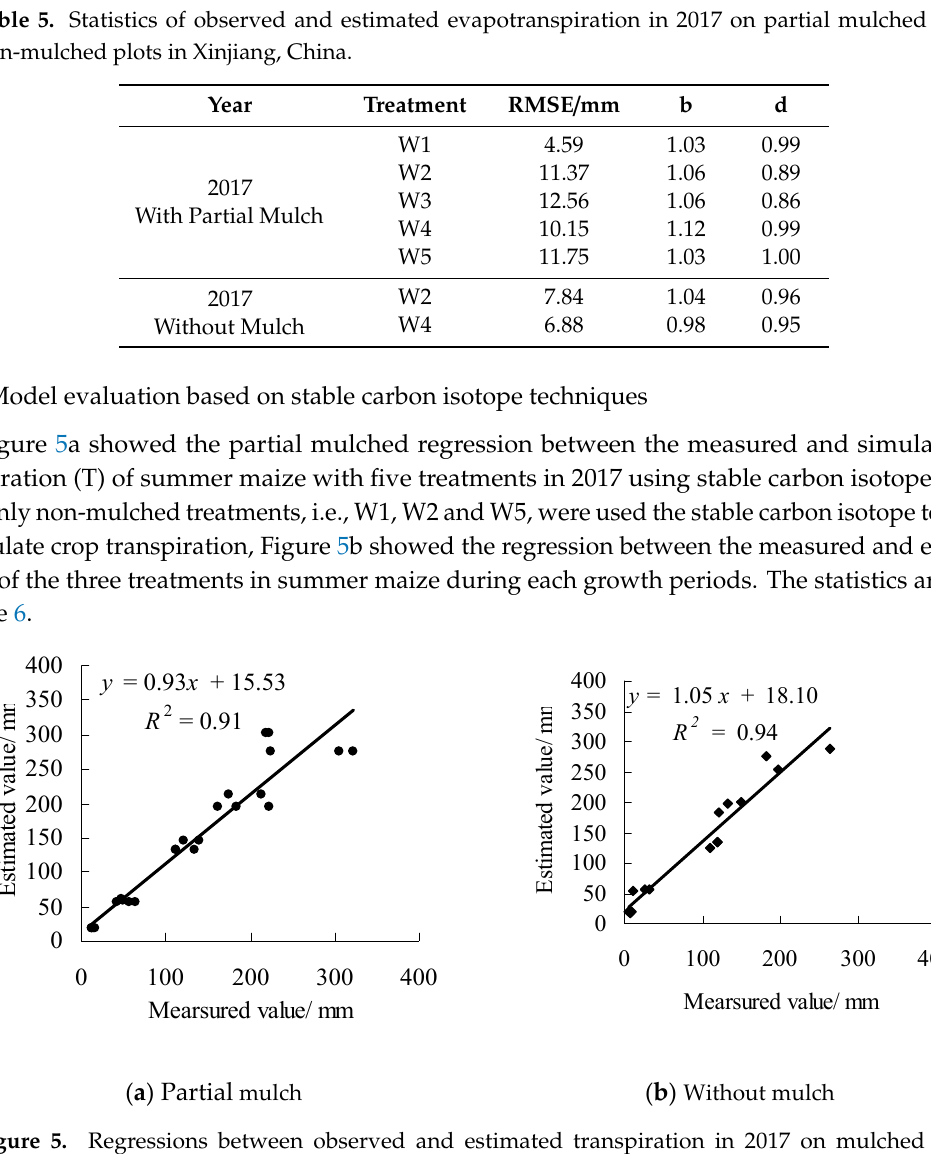
Figure 5. Regressions between observed and estimated transpiration in 2017 on mulched and non-mulched plots in Xinjiang, China. ( a ) Partial mulch; ( b ) without mulch. Table 6. Statistics of observed and estimated transpiration for mulched and non-mulched plots in 2017 in Xinjiang, China.